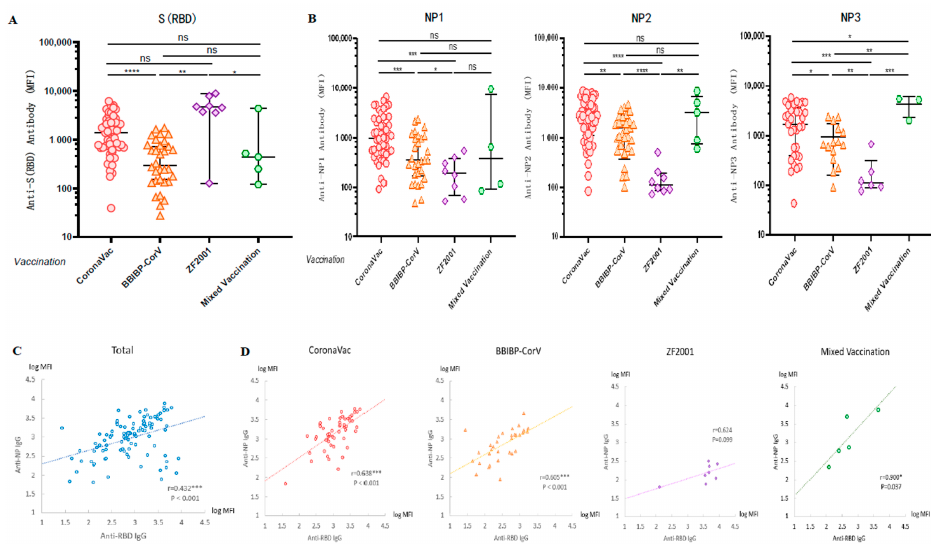
Figure 3. Vaccination with different types of COVID-19 vaccines induced high levels of anti-SARS-CoV-2 antibodies. ( A , B ) Cross-sectional observation of IgG levels of anti-RBD and anti-NP produced in vivo after vaccination with different types of vaccines. MFI values were logged and then compared two-by-two for multiple sample means using the LSD (Least-Significant Difference) test. ( C , D ) Analysis of the correlation between anti-RBD and anti-NP IgG in sera after vaccination. Nor- mally distributed MFI values were logged, and correlation analysis was performed using Pearson test. * p < 0.05, ** p < 0.01, *** p < 0.001, and **** p < 0.0001.